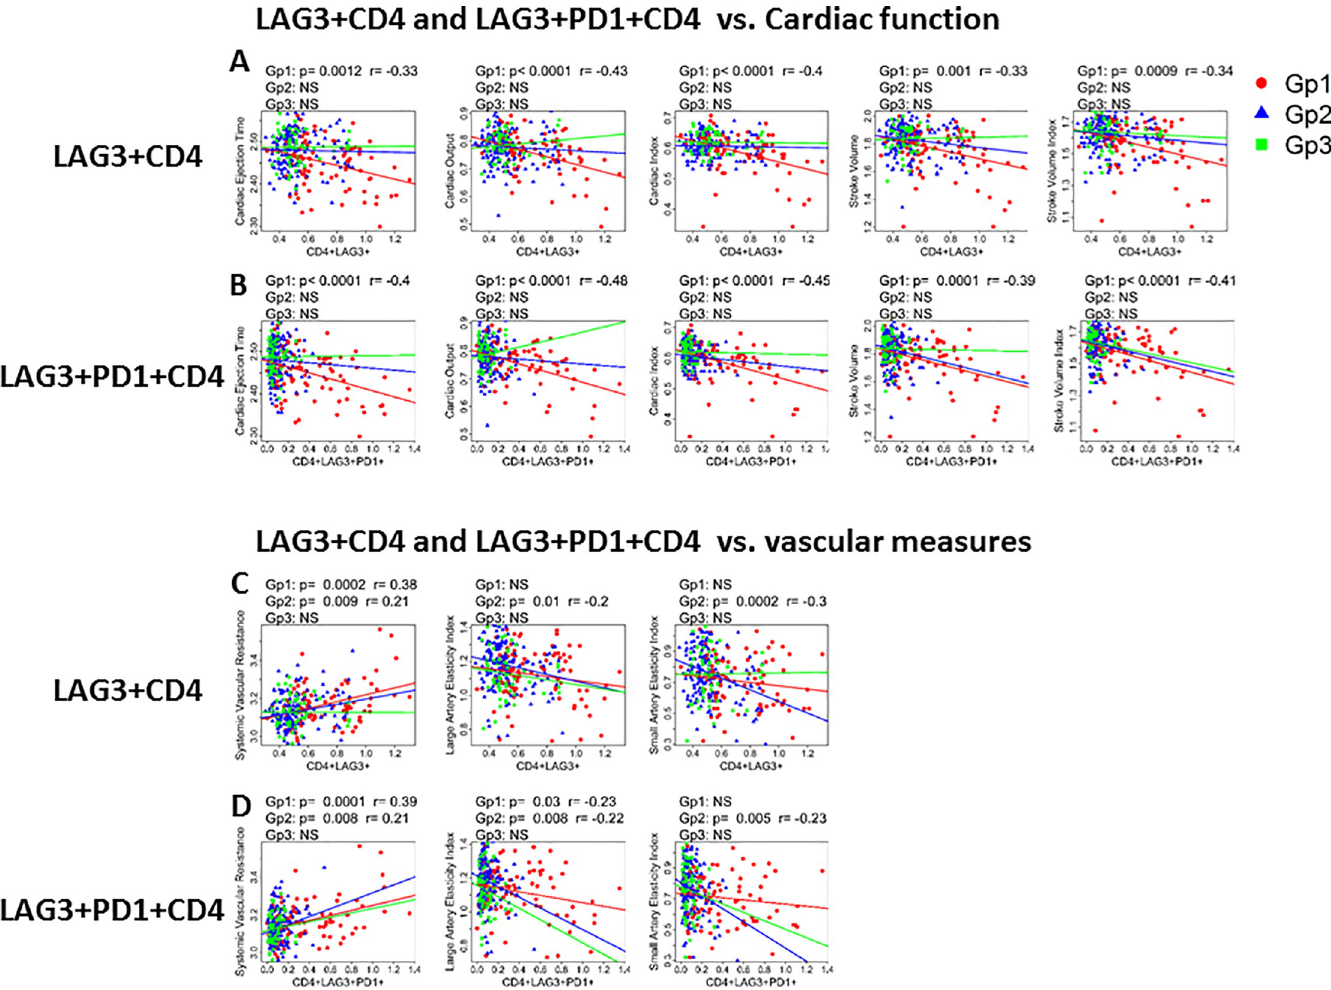
Fig 5. Markers of cardiac function and arterial stiffness correlate with CPI expression on CD4 T cells. Linear regression analysis showing correlation of cardiac function with A), LAG-3+ CD4 T cells; B), LAG-3+PD1+ CD4 T cells. Correlation of arterial stiffness with C), LAG-3+CD4 and D), LAG-3+PD1+ CD4 T cells shown for ART na ï ve (Gp1, red), Virologically suppressed (Gp2, blue) and healthy controls, (Gp3, green). Pearson correlation was performed based on data distribution; a p value of < 0.05 was considered as